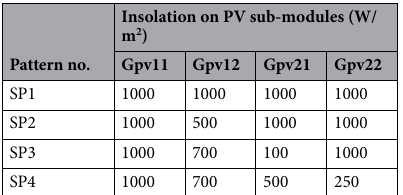
Table 2. The four shading patterns used in this study.